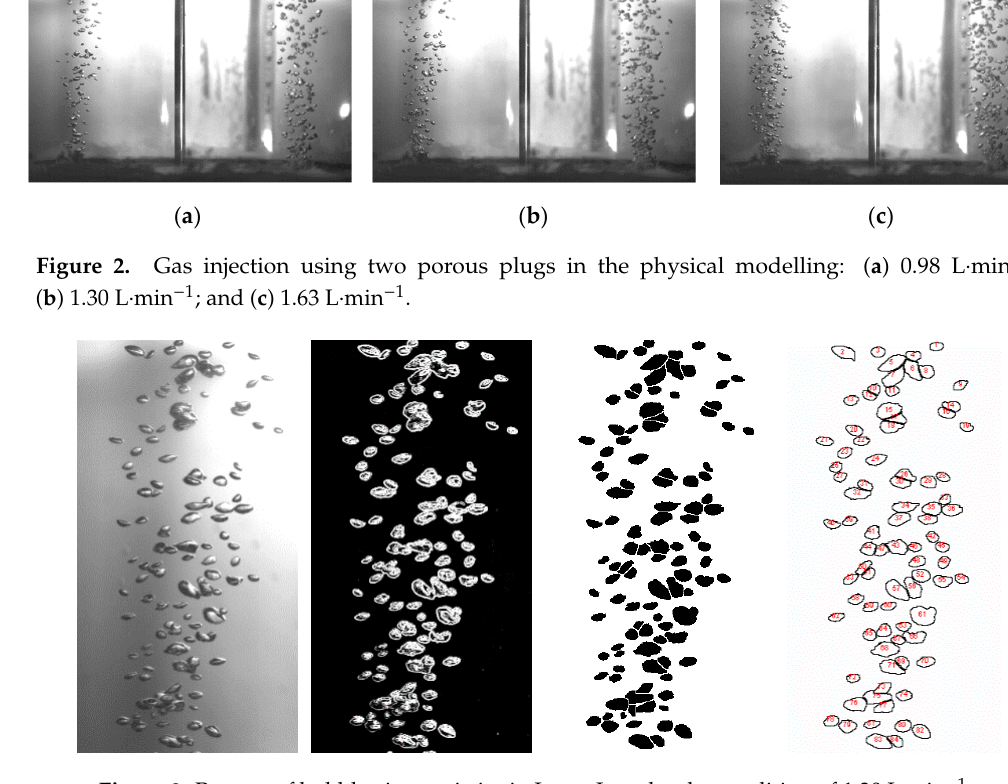
Figure 3. Process of bubble-size statistics in ImageJ, under the condition of 1.30 L ‧ min − 1 .